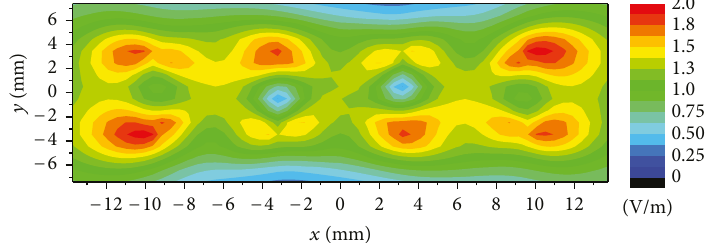
Figure 6: Lattice A: results received theoretically. The absolute value of the electric fi eld intensity on planes inside the host and 2 mm o ff from “ front side ” on which the x -polarized plane wave of E = 1 V/m and f = 2 035 GHz impinges perpendicularly. Geometry of Lattice A: s = 0 = 3 75 mm , and r = 2 56 mm and size of lattice plus host: D = 27 46mm , D = 14 78 mm , and D = 17 78 mm . 6 34mm , r e h hx hy hz